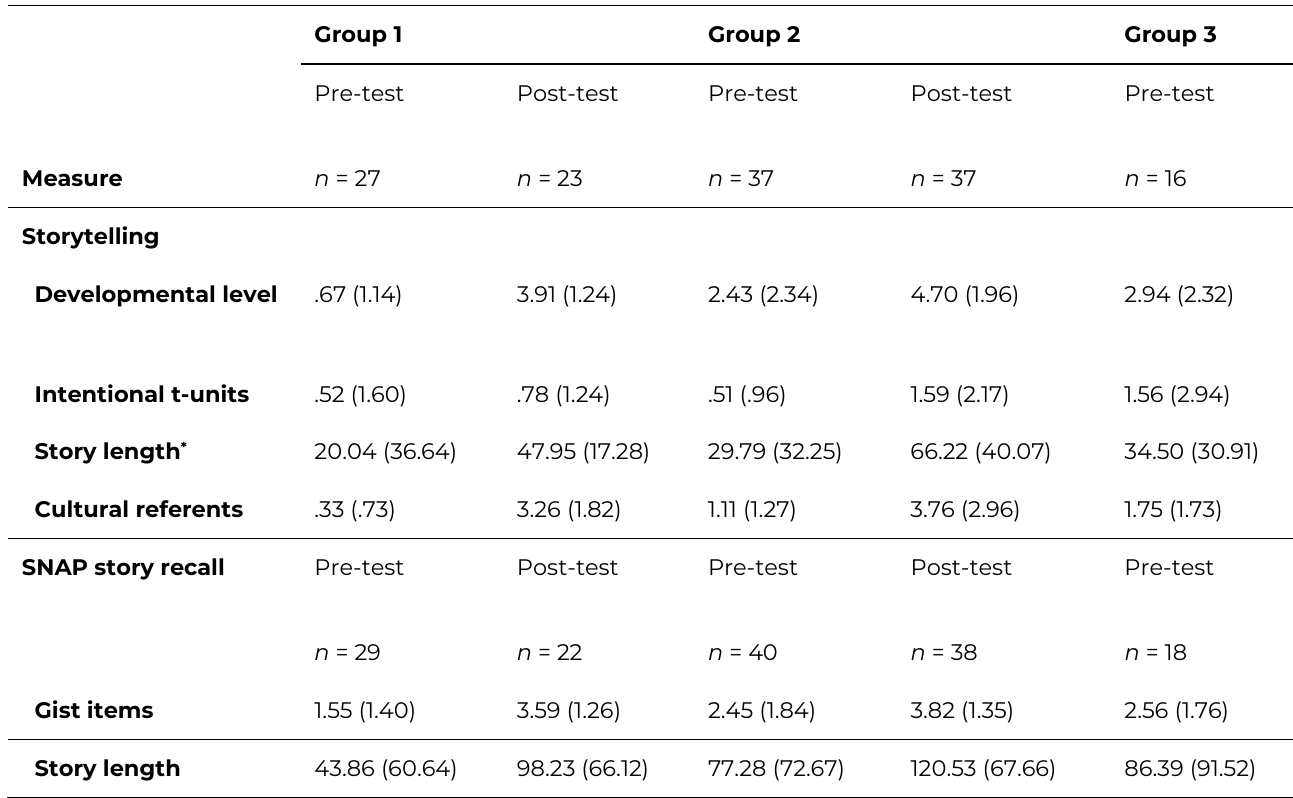
Table 5: Means (SD) of measures of storytelling and story